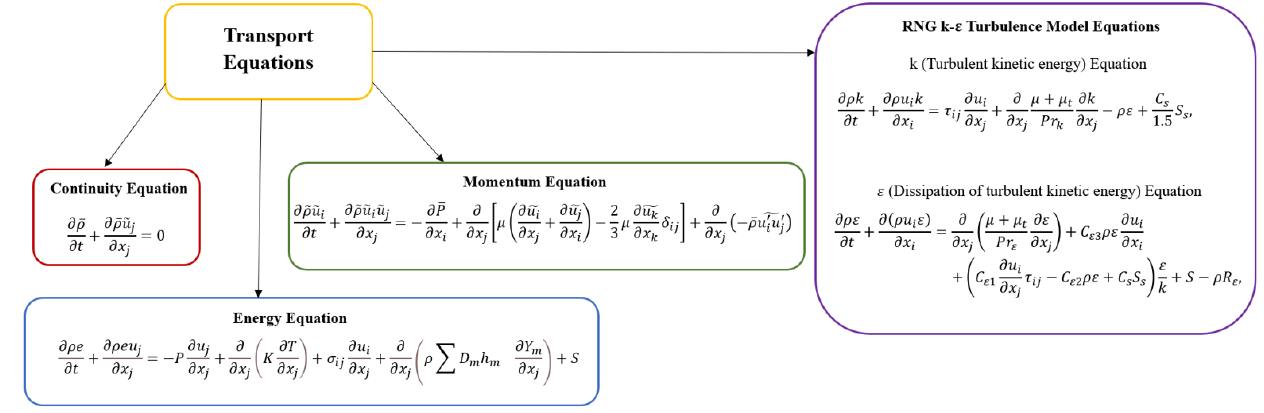
Figure 6. Transport equations. Figure 6. Transport